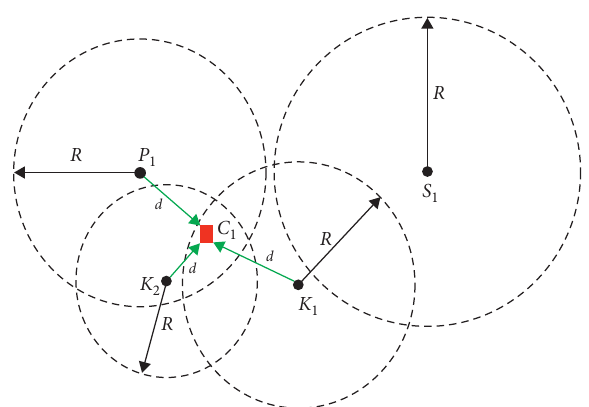
Figure 3: The combined effect of the educational facilities on a